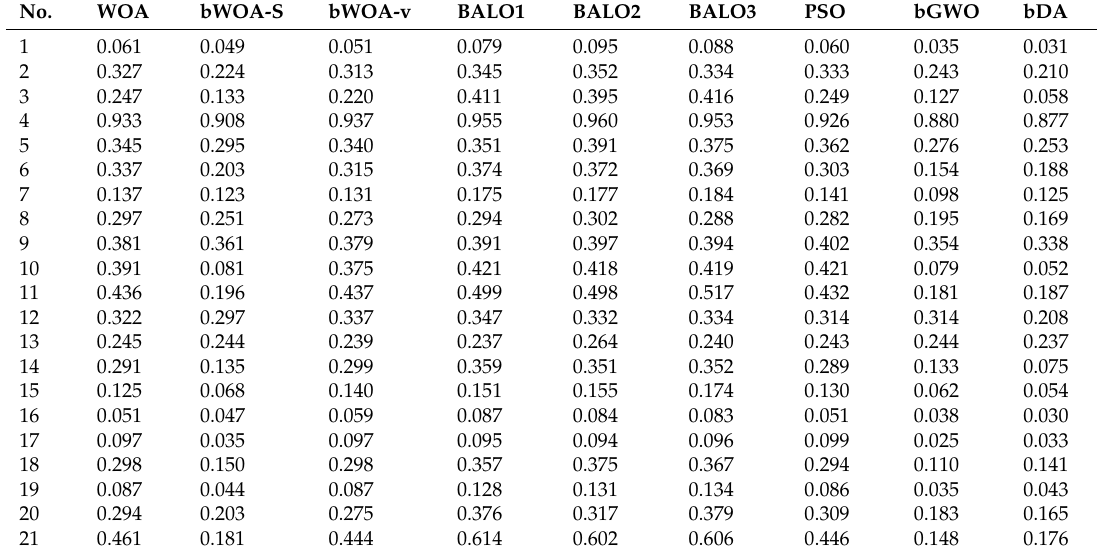
Table 3. Statistical mean fitness measure on the different datasets calculated for the compared algorithms using small initialization.